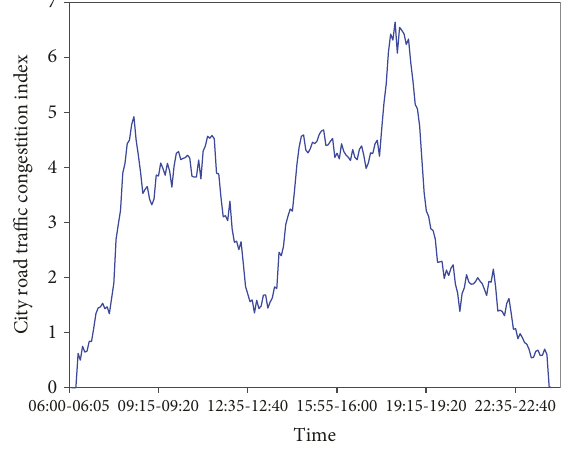
Figure 5: City road tra ffi c congestion index.